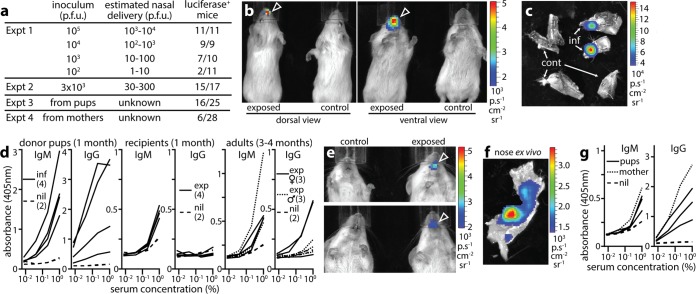
MCMV transmission is a nasal infection. (a) Experiment 1 (Expt 1) established a minimum in vivo infectious dose for giving M78-LUC i.n. in 1 µl to BALB/c pups (103 PFU). Experiment 2 tracked infection after giving the minimum infectious dose i.n. three times per mouse. Experiment 3 tracked M78-LUC acquisition by naive recipient pups cocaged with infected donor pups. Experiment 4 tracked M78-LUC acquisition by pups from infected parents. (b) Live images of luciferase expression from a mouse acquiring M78-LUC infection in experiment 3 (exposed) compared with an unexposed control mouse. See also Fig. S3 in the supplemental material. (c) Ex vivo images of luciferase expression in the nose of an infected (inf) mouse from experiment 3 (n = 1), with control (cont) unexposed noses shown for comparison (n = 2). Each nose was split sagitally to reveal the septum and so increase imaging sensitivity. (d) ELISA of MCMV-specific serum IgM and IgG from infected (inf) donor pups, exposed (exp) recipient pups, and exposed male and female parents in experiment 3. Age-matched, naive controls (nil) are also shown. The duration of cocaging with MCMV-infected pups is shown. (e) Luciferase signals in exposed (arrowheads) and unexposed control pups of experiment 4. See also Fig. S4 in the supplemental material. Although the signal in the top panel looks more oral than nasal, this is due to nasal signal being seen best through the mouth because of less light attenuation along this line of sight. Dissection (see panel f) confirmed that the signal was nasal in origin. (f) Dissection of the mouse in the top panel in panel e showing luciferase expression in the nasal sinuses. Other tissues were negative. (g) ELISA of MCMV-specific serum IgM and IgG from exposed pups in experiment 4 (n = 3), their mother (n = 1), and control, unexposed pups (nil) (n = 2).